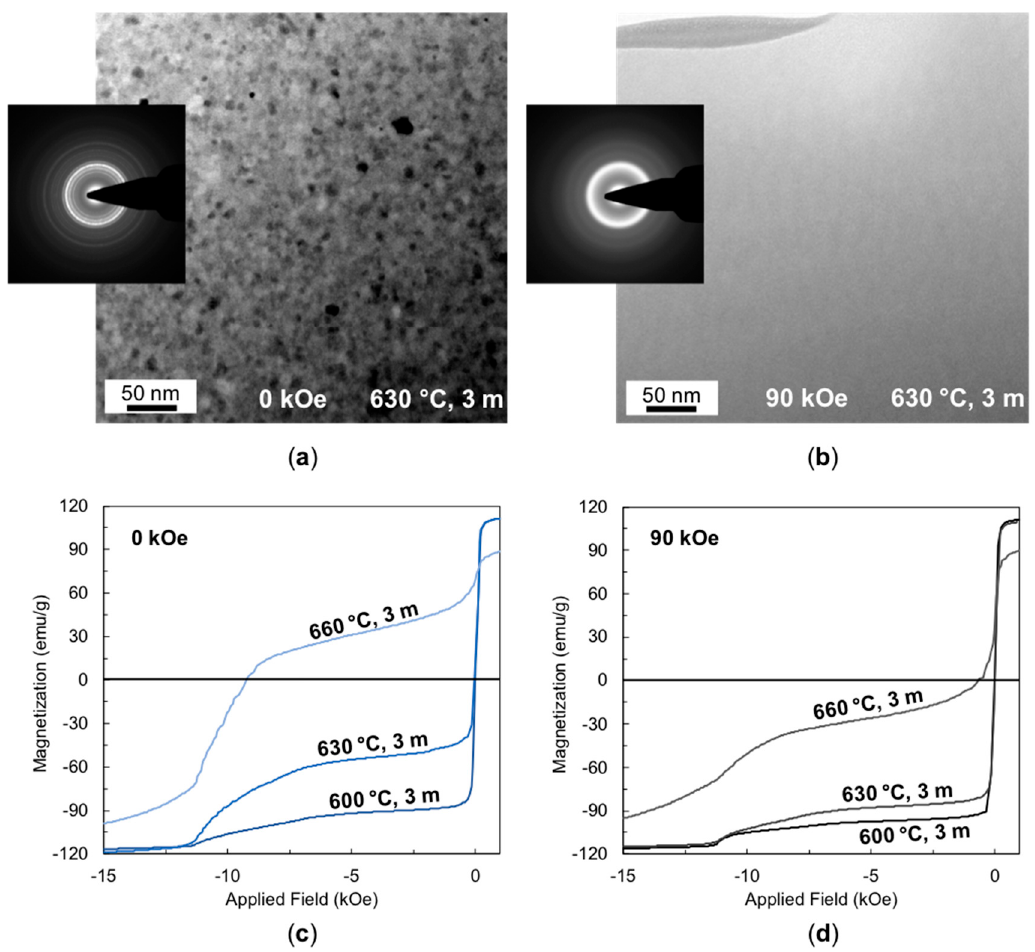
Figure 3. TEM bright field micrographs with SAD pattern insets from Nd 2 Fe 14 B ribbons annealed at 630 ◦ C for 3 min at ( a ) zero-field and ( b ) in an applied field of 90 kOe. VSM demagnetization curves from samples annealed at ( c ) zero-field and ( d ) in an applied field of 90 kOe showing the magnetic behavior evolution with increasing annealing temperature.